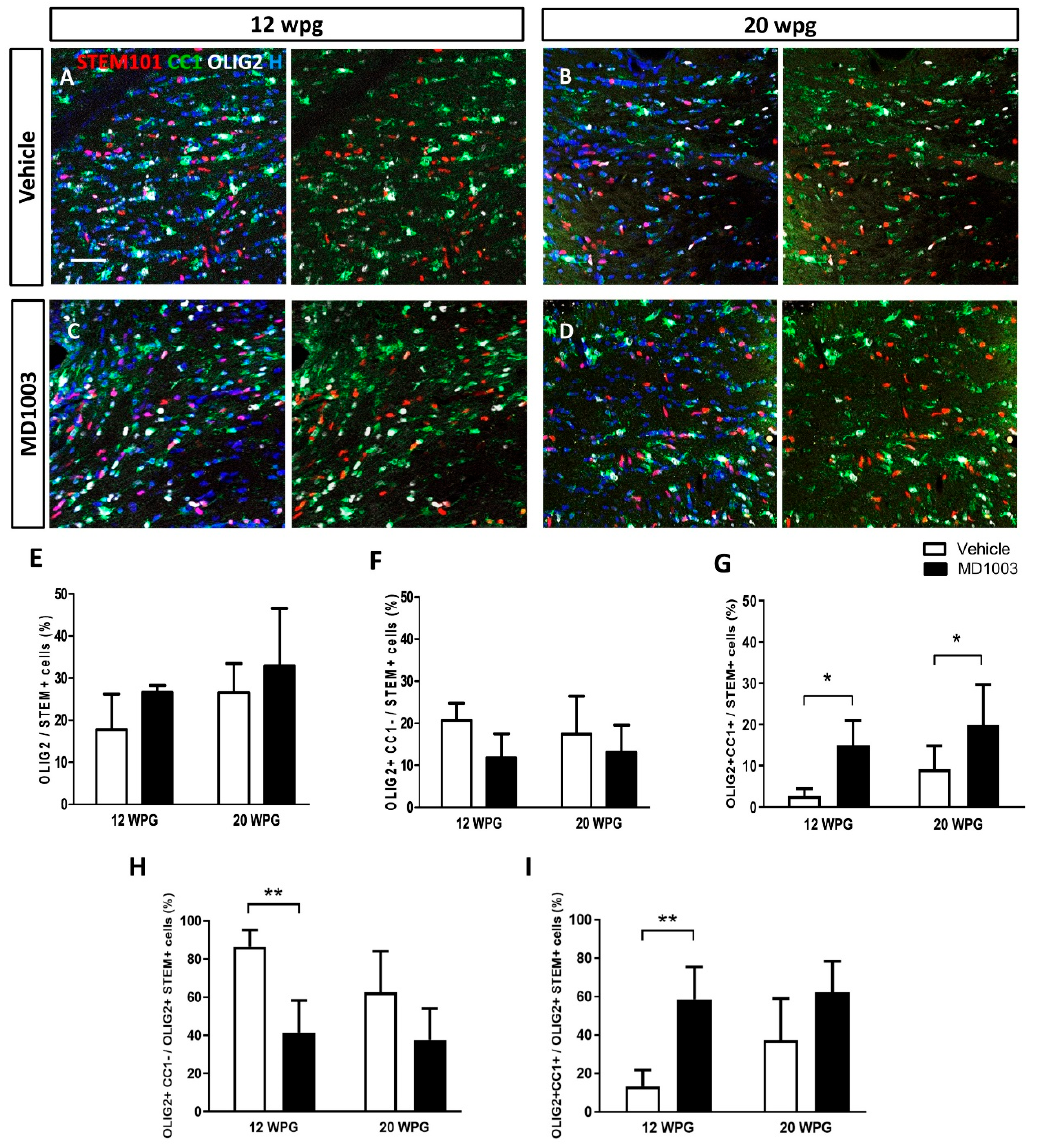
Figure 4. MD1003 increases the percentage of differentiated hOPCs. ( A – D ) STEM101+ human cells (red) are found in all the grafted animals 12 wpg or up to 20 wpg. ( E ) The percentage of total hOLs (OLIG2, in white) tends to increase over time, and in MD1003- vs. vehicle-treated animals. ( F ) While the percentage of OLIG2+CC1- hOPCs (CC1 in green) tends to slightly decrease overtime, MD1003-treated mice contain significantly higher numbers of differentiated OLIG2+CC1+ hOLs both at 12 wpg and 20 wpg ( G ). ( H , I ) In the oligodendroglial lineage (OLIG2+STEM+), MD1003 significantly decreases the percentage of CC1- hOPCs but increases the percentage of CC1+ hOLs. Two-way ANOVA followed by Tukey’s multiple comparison test ( n : 3–6 per groups). * p < 0.05, and ** p < 0.01. Error bars represent SEMs. WPG: weeks post graft, scale bar: 50 µm.